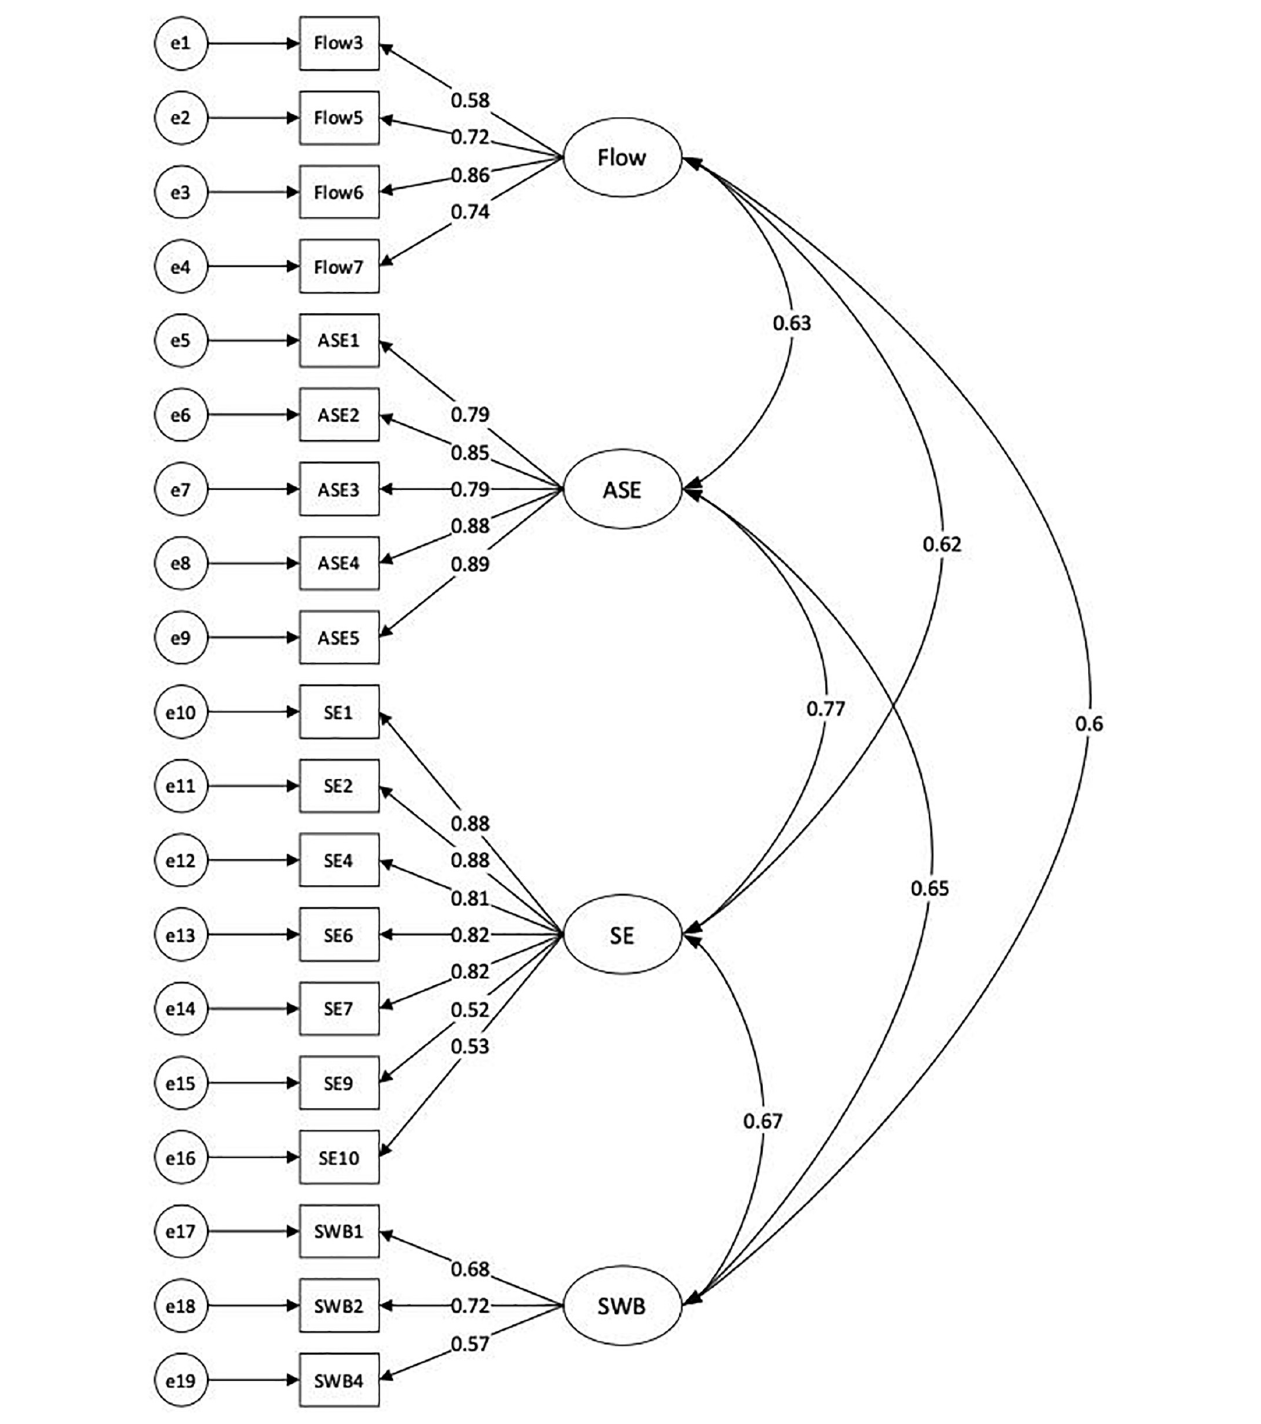
FIGURE 2 | The measurement model. ASE, academic self-efficacy; SE, self-esteem; SWB, subjective well-being.